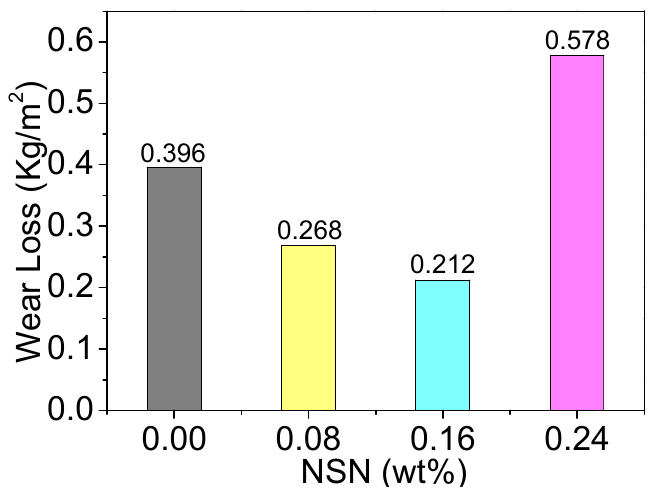
Figure 4. Wear loss per unit area with different contents of NSN.